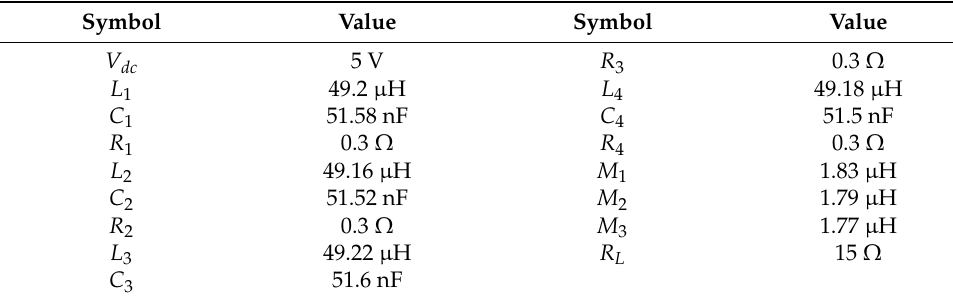
Figure 8. Photograph of the experimental setup. Table 2. Main parameters of the proposed domino WPT system.